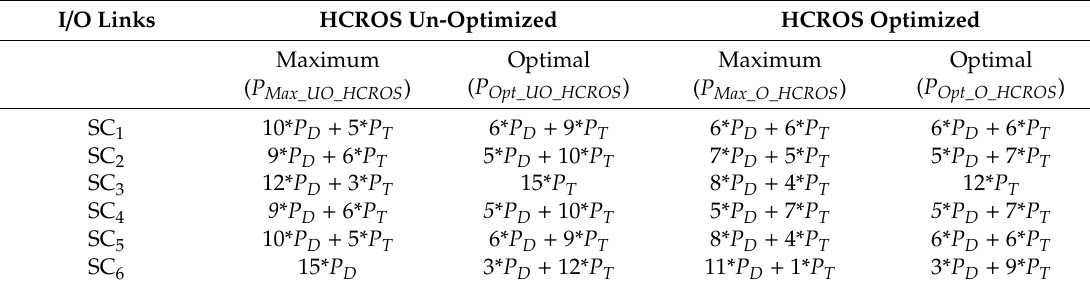
Table 11. Power consumption of OSEs in